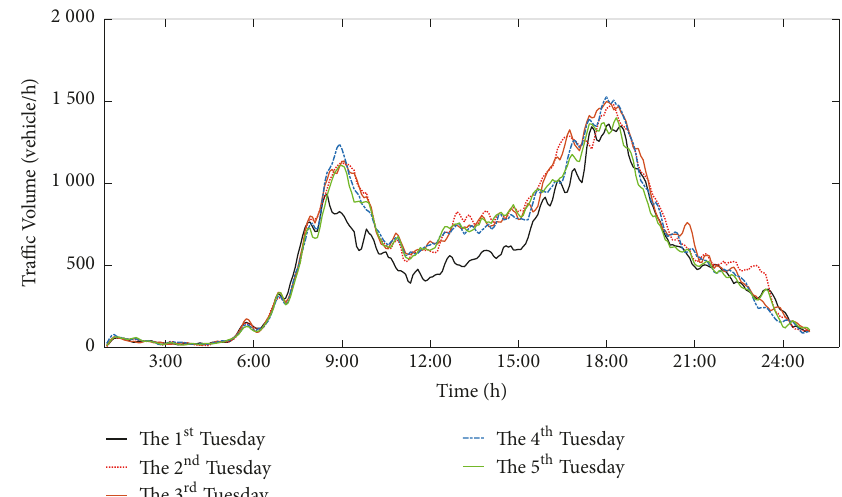
Figure 4: Traffic flows for 5 consecutive Tuesdays in the station